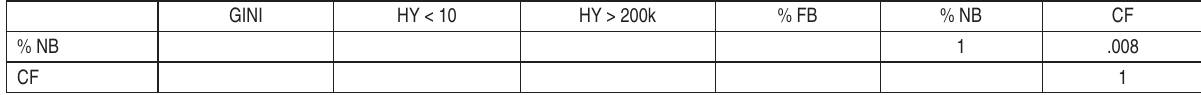
Table 5 (cont.). Inequality partial